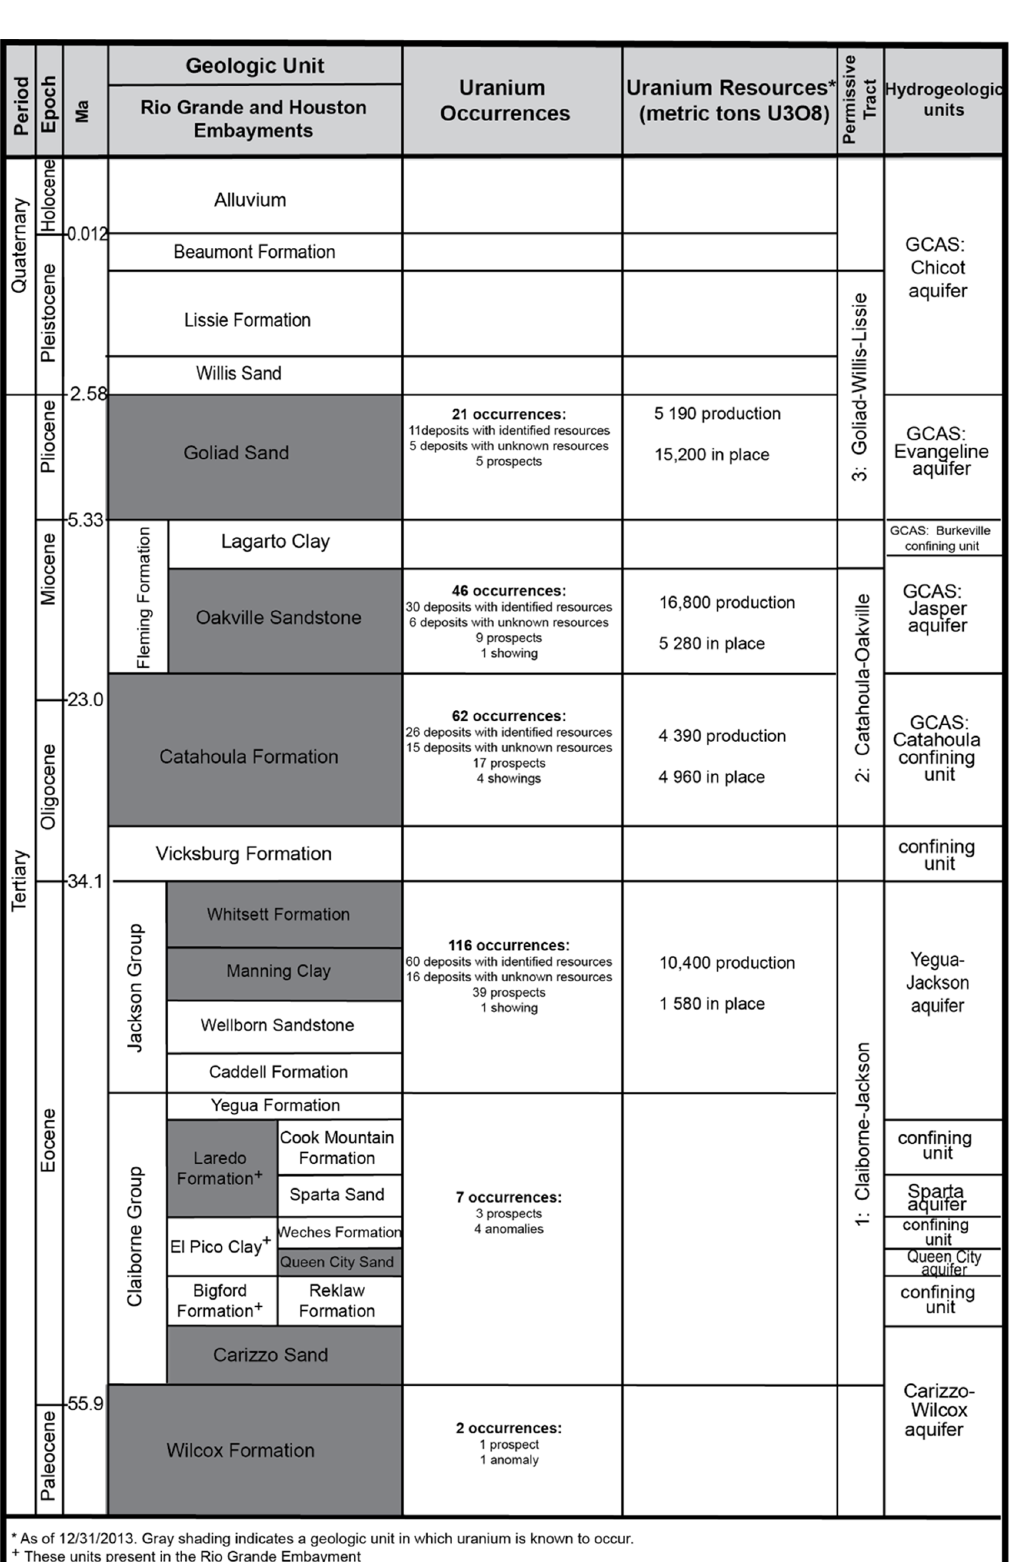
Figure 4. Stratigraphic section showing Tertiary and Quaternary geologic units along the Texas Gulf Coast, formations that host uranium deposits and occurrences, known uranium resources, permissive tracts, and hydrogeologic units (aquifers and confining units). Modified from [16]. Stratigraphy from [25,26]. Geologic names conform to the USGS National Geologic Map Database [27]. Epoch boundary ages from [28]. Permissive tract extents from [13,16]. Hydrogeologic units from